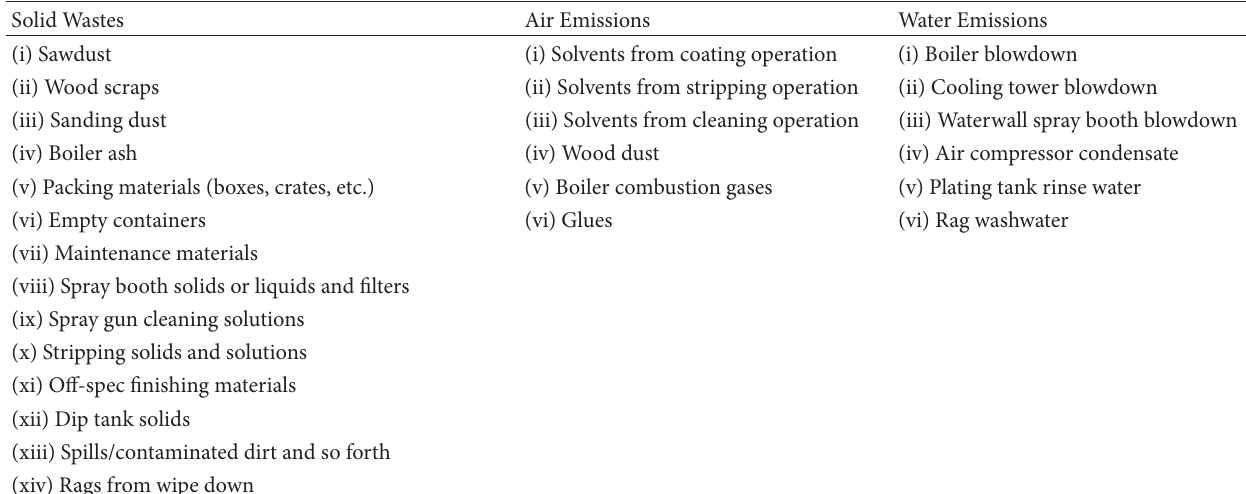
Table 1: Typical waste streams from the wood furniture